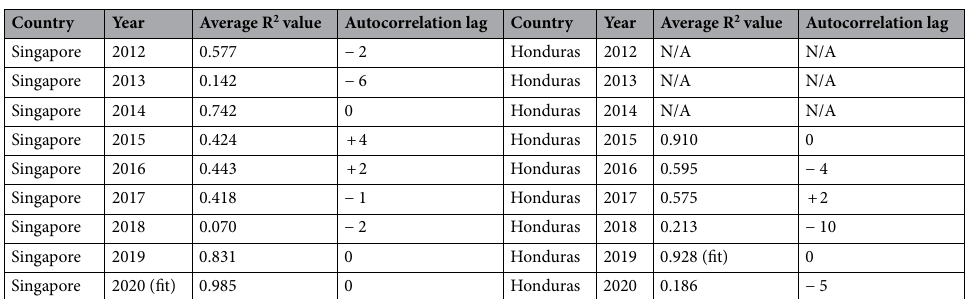
Table 4. Results of statistical testing for seasonal models. "Average" refers to the average of five displayed forward simulations. Lag times were rounded to nearest whole number if result was a